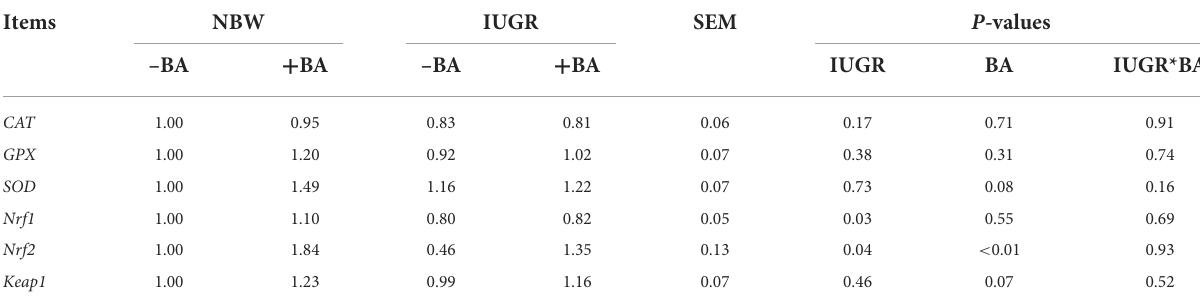
TABLE 6 Effects of dietary bile acid (BA) supplementation on liver antioxidant-related gene expression in weaned piglets with NBW and IUGR.